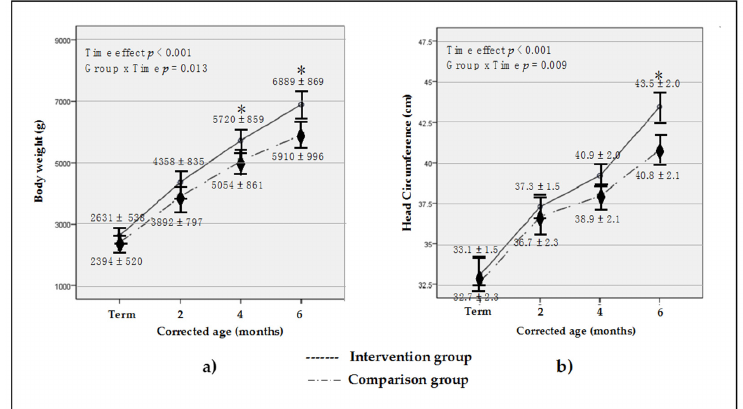
Figure 2. Anthropometric measurement of body weight, ( a ) and head circumference, ( b ) of the intervention and comparison group ( n = 22). Data are reported as unadjusted mean ± SD. * denote a significant difference between groups at a specific time point with intervention greater than the comparison group (body weight at 4 ‐ moCA, p = 0.001, and 6 ‐ moCA, p < 0.001; head circumference at 6 ‐ moCA, p < 0.001). Table 7. Comparisons of growth status of preterm infants between the groups.